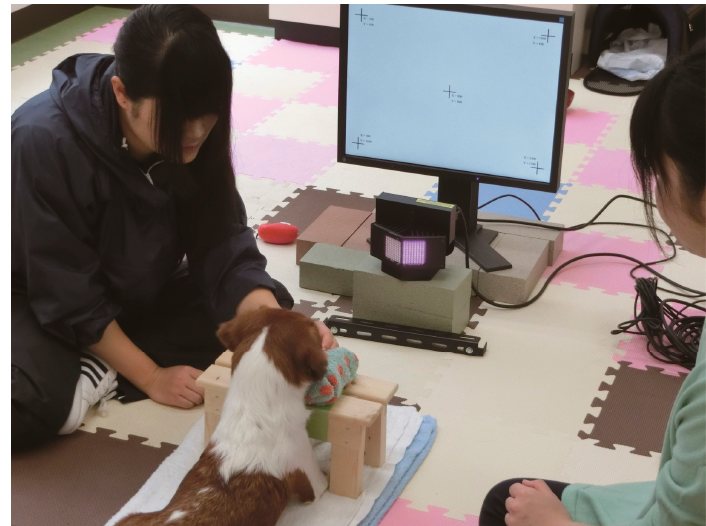
Figure 1. Subject dogs lied down in front of an eye-tracking camera and display. During calibration and the experimental session, the subject put his / her jaws on a purpose-designed chin rest.